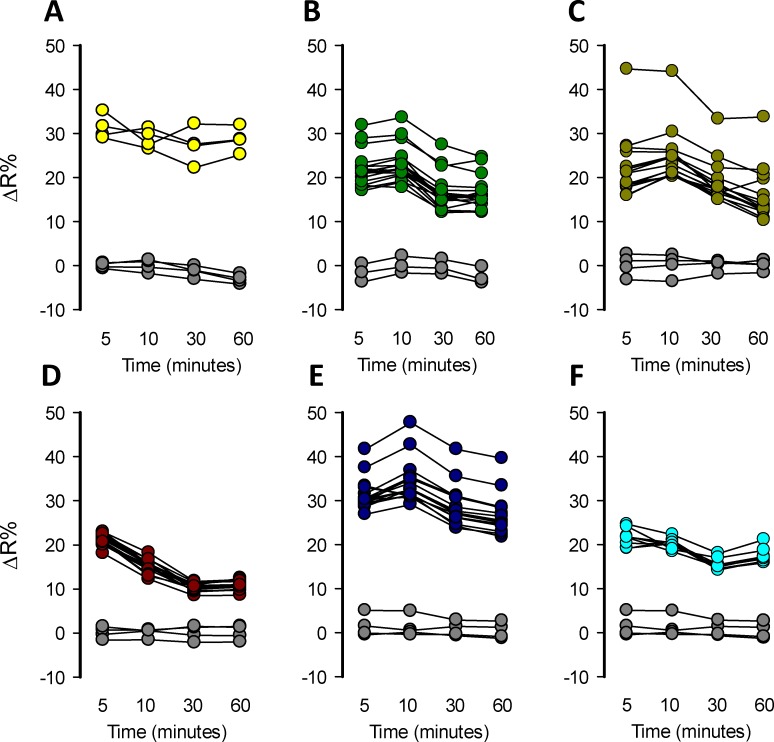
Single-well detection of lactate accumulation induced by mitochondrial toxicants.Mitochondrial dysfunction induced by mitochondrial toxicants was detected in MitoTox Reporter cells in 96 well plates. Measurements using a standard multiplate reader were performed at 5, 10, 30, and 60 minutes. A) 10 mM Lactate, B) 32 μM rotenone, C) 16 μM antimycin, D) 5 mM azide, E) 80 μM oligomycin and F) 10 μM myxothiazol. Solvent control (gray circles): KRH buffer for azide, 0.8% DMSO for rotenone, oligomycin, and myxothiazol and 0.16% ethanol for antimycin. All the experiments were performed at 37°C.